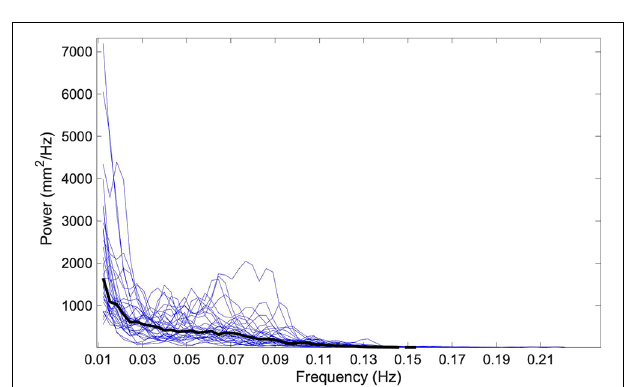
FIGURE 7 | The one-sided power spectral density (PSD) of the ML CoP tracing is shown using blue traces for each of the 33 subjects. The median spectral density calculated at each discrete frequency is shown by a solid black line. 95% of the power in the CoP signal is housed below 0.11 Hz; this is below the frequency for any of the roll tilt perceptual thresholds that were measured (0.2, 0.5, and 1 Hz). CoP, Center of Pressure; ML, mediolateral. sequalae of vestibular impairment such as gaze instability, cognitive impairment, and autonomic dysregulation. Further, in our multivariable regression models where we controlled for elements common to the three threshold frequencies